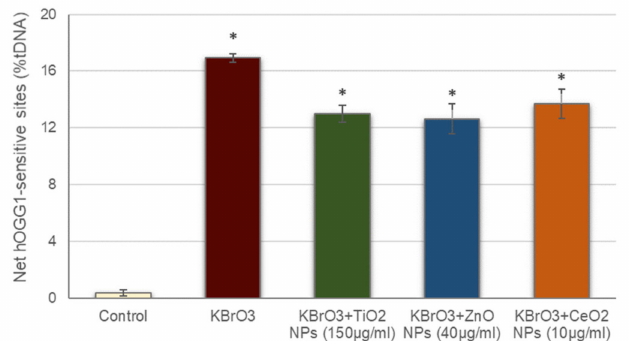
Figure 3. Assessment of NPs interference with hOGG1 enzyme activity. Columns represent mean values and error bars indicate the standard errors. * p < 0.01, significant difference with regard to the